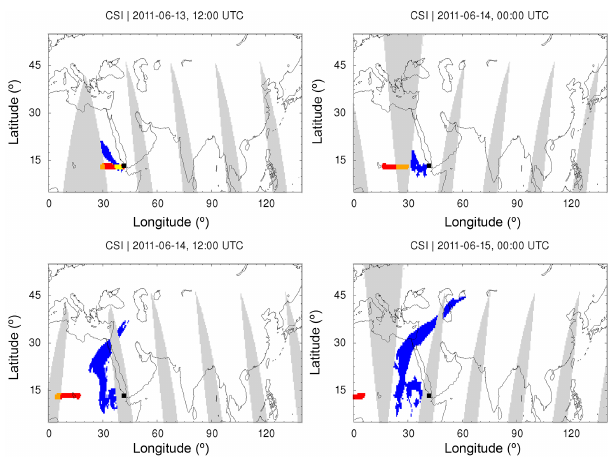
Figure 2. Unit simulation for the Nabro case study with air parcels initialized around 13 June, 00:00UTC and 16.5km altitude. The CSI analysis is performed on a 1 ◦ × 1 ◦ longitude–latitude grid. Gray color indicates missing satellite data. Orange color corresponds to positive model forecasts, but lack of satellite data. Yellow color in- dicates positive forecasts and positive satellite observations. Blue color corresponds to negative forecasts with positive observations. Red color corresponds to positive forecasts with negative observa- tions. The black square shows the location of the Nabro volcano.